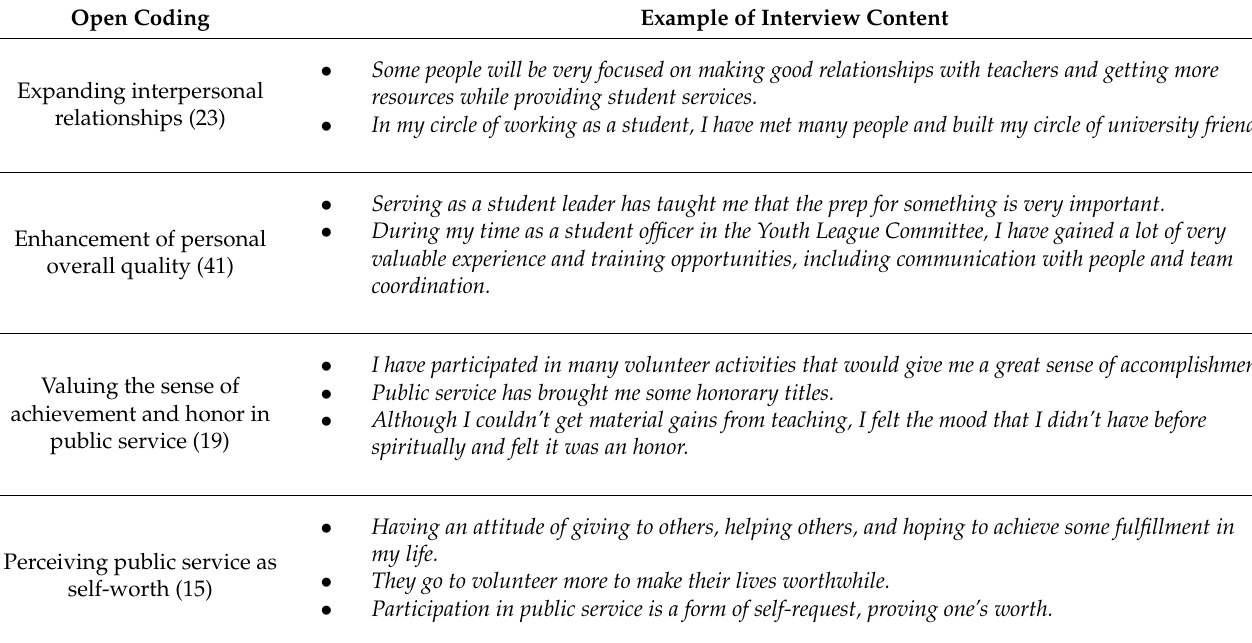
Table 7. Material information of the sub-node “self-improvement” of axial